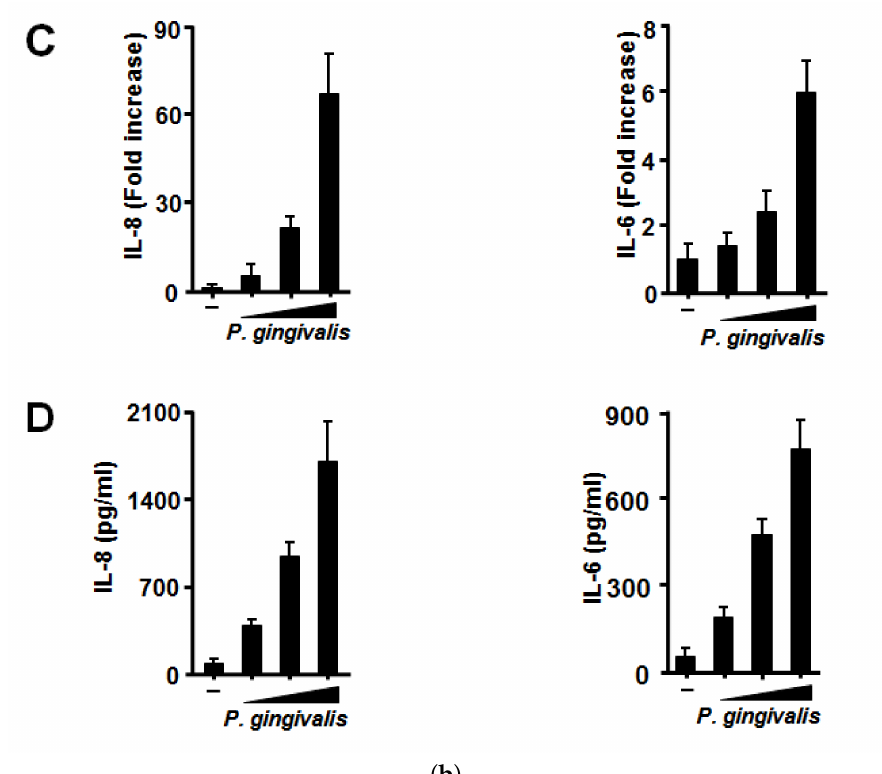
Figure 1. Porphyromonas gingivalis -induced mRNA expression and protein production of proinflammatory cytokines by human bronchial epithelial cells. BEAS-2B cells were exposed to heat-inactivated P. gingivalis (1 × 10 8 CFU / mL) for the indicated times ( A , B ) and at di ff erent bacterial cell densities (1 × 10 7 , 0.5 × 10 8 , or 1 × 10 8 CFU / mL) for 3 h ( C ) or 12 h ( D ). The cells were harvested, and IL-8 and IL-6 mRNA levels were measured using real-time polymerase chain reaction with specific primers. The mRNA levels were normalized to the GAPDH mRNA level and expressed as fold increases. IL-8 and IL-6 protein levels were determined by enzyme-linked immunosorbent assay and expressed as pg / mL. These experiments were performed in triplicate, and data are presented as the mean ±